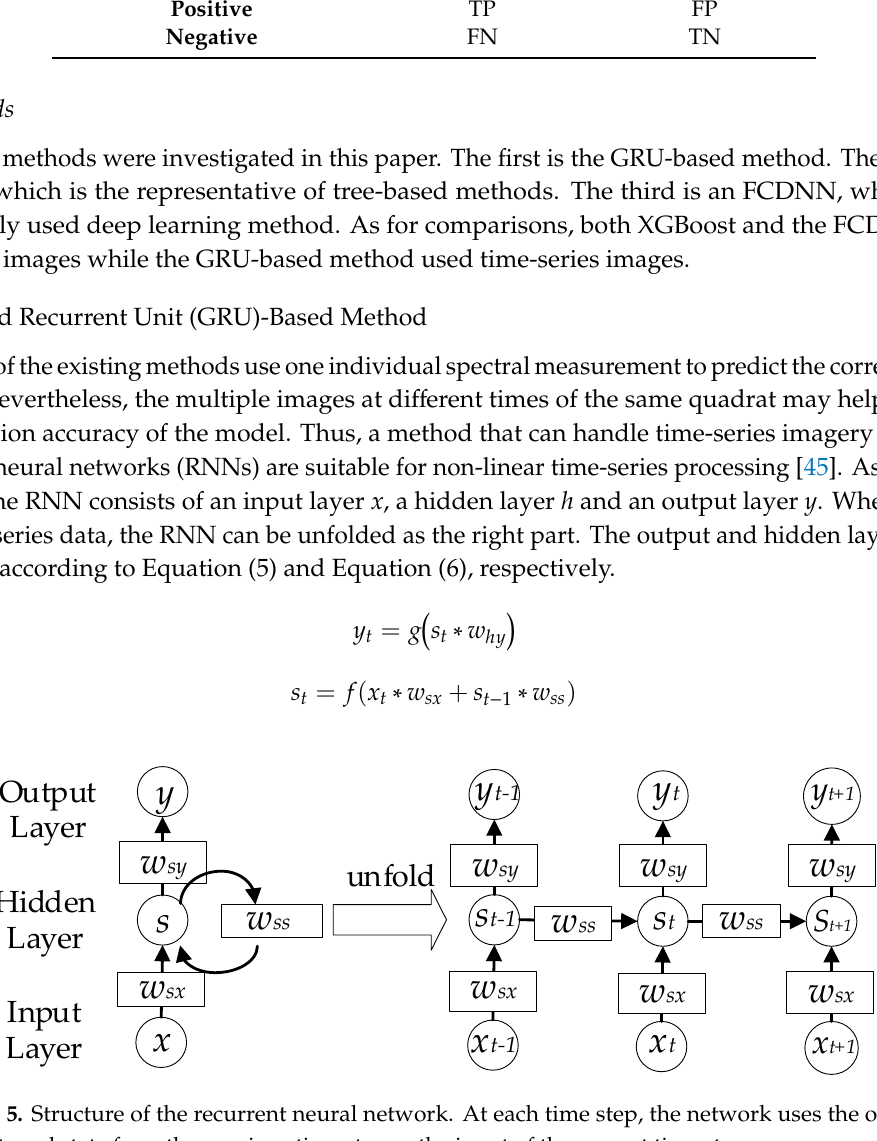
Figure 5. Structure of the recurrent neural network. At each time step, the network uses the output and internal state from the previous time step as the input of the current time step.